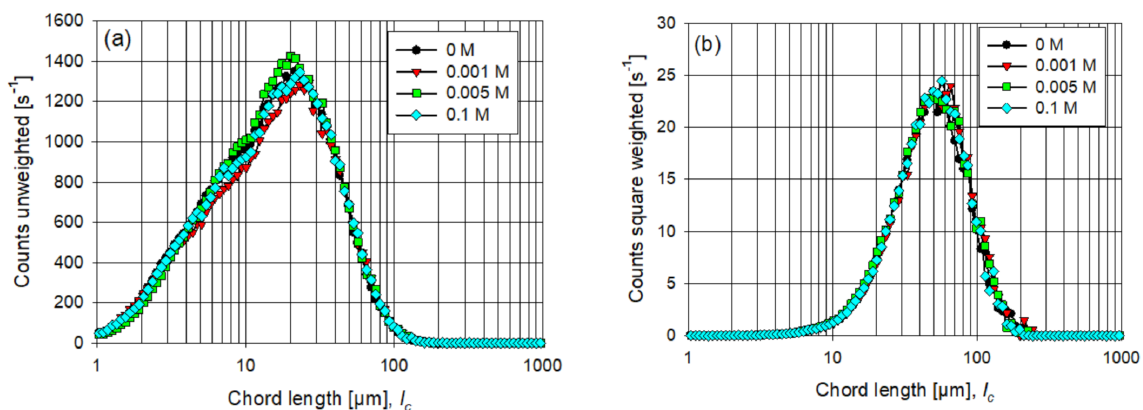
Figure 5. Unweighted ( a ) and squared-weighted ( b ) size distribution of kaolin suspension without flocculant at differ- ent